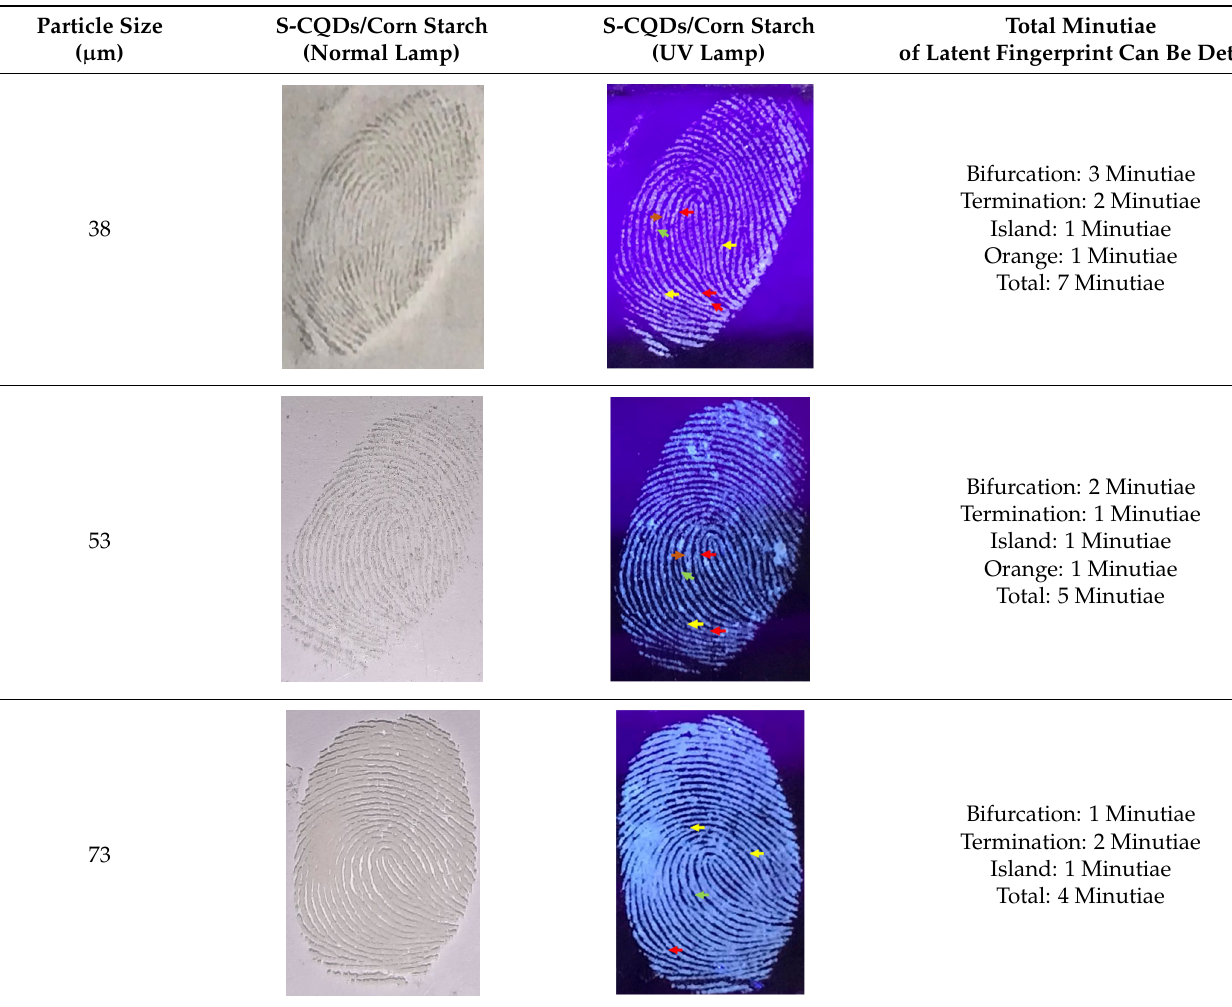
Table 2. Detection of latent fingerprints using different particle sizes of S-CQDs/corn starch under normal and UV lamps.